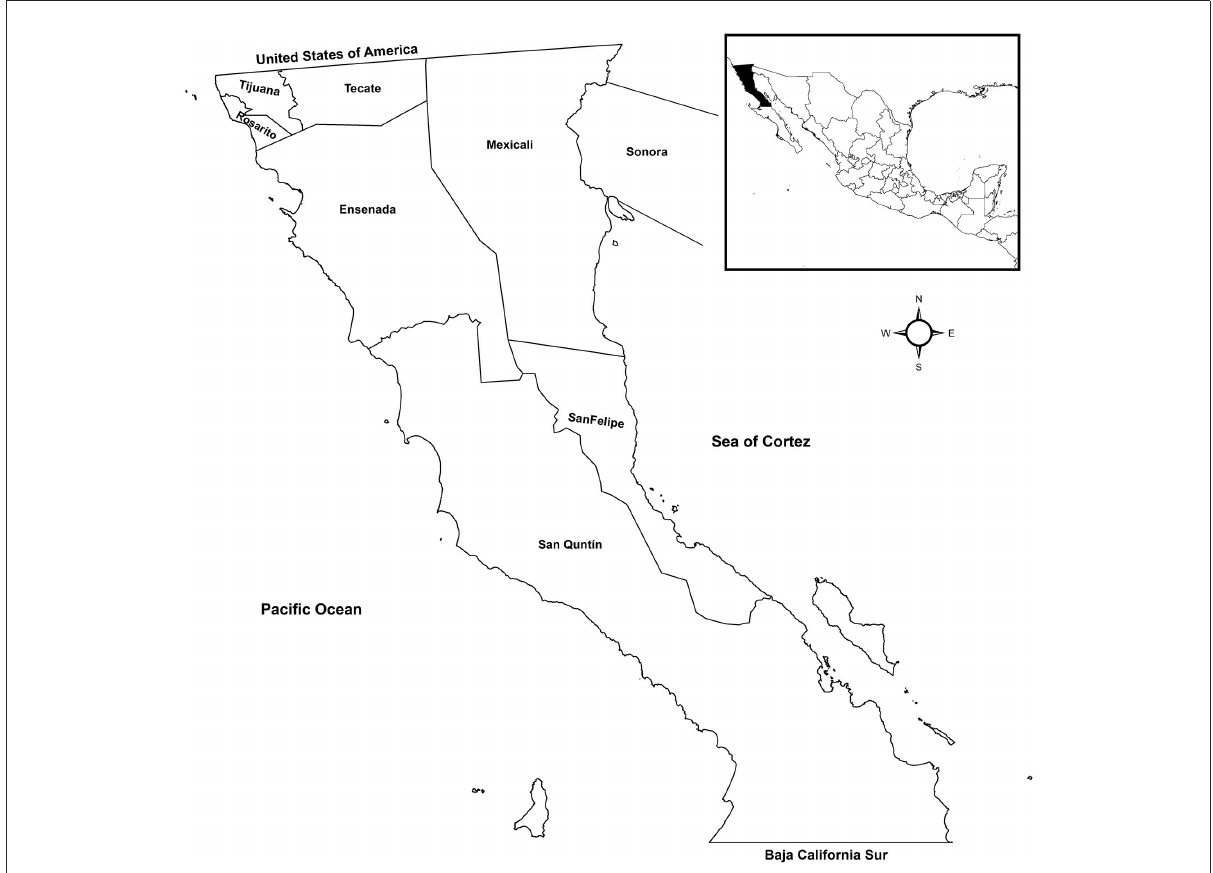
FIGURE1 Map of Baja California, Mexico health jurisdictions included in the study. JI, Mexicali and San Felipe; JII, Tijuana, Rosarito, and Tecate; JIII, Ensenada; and JIV, San